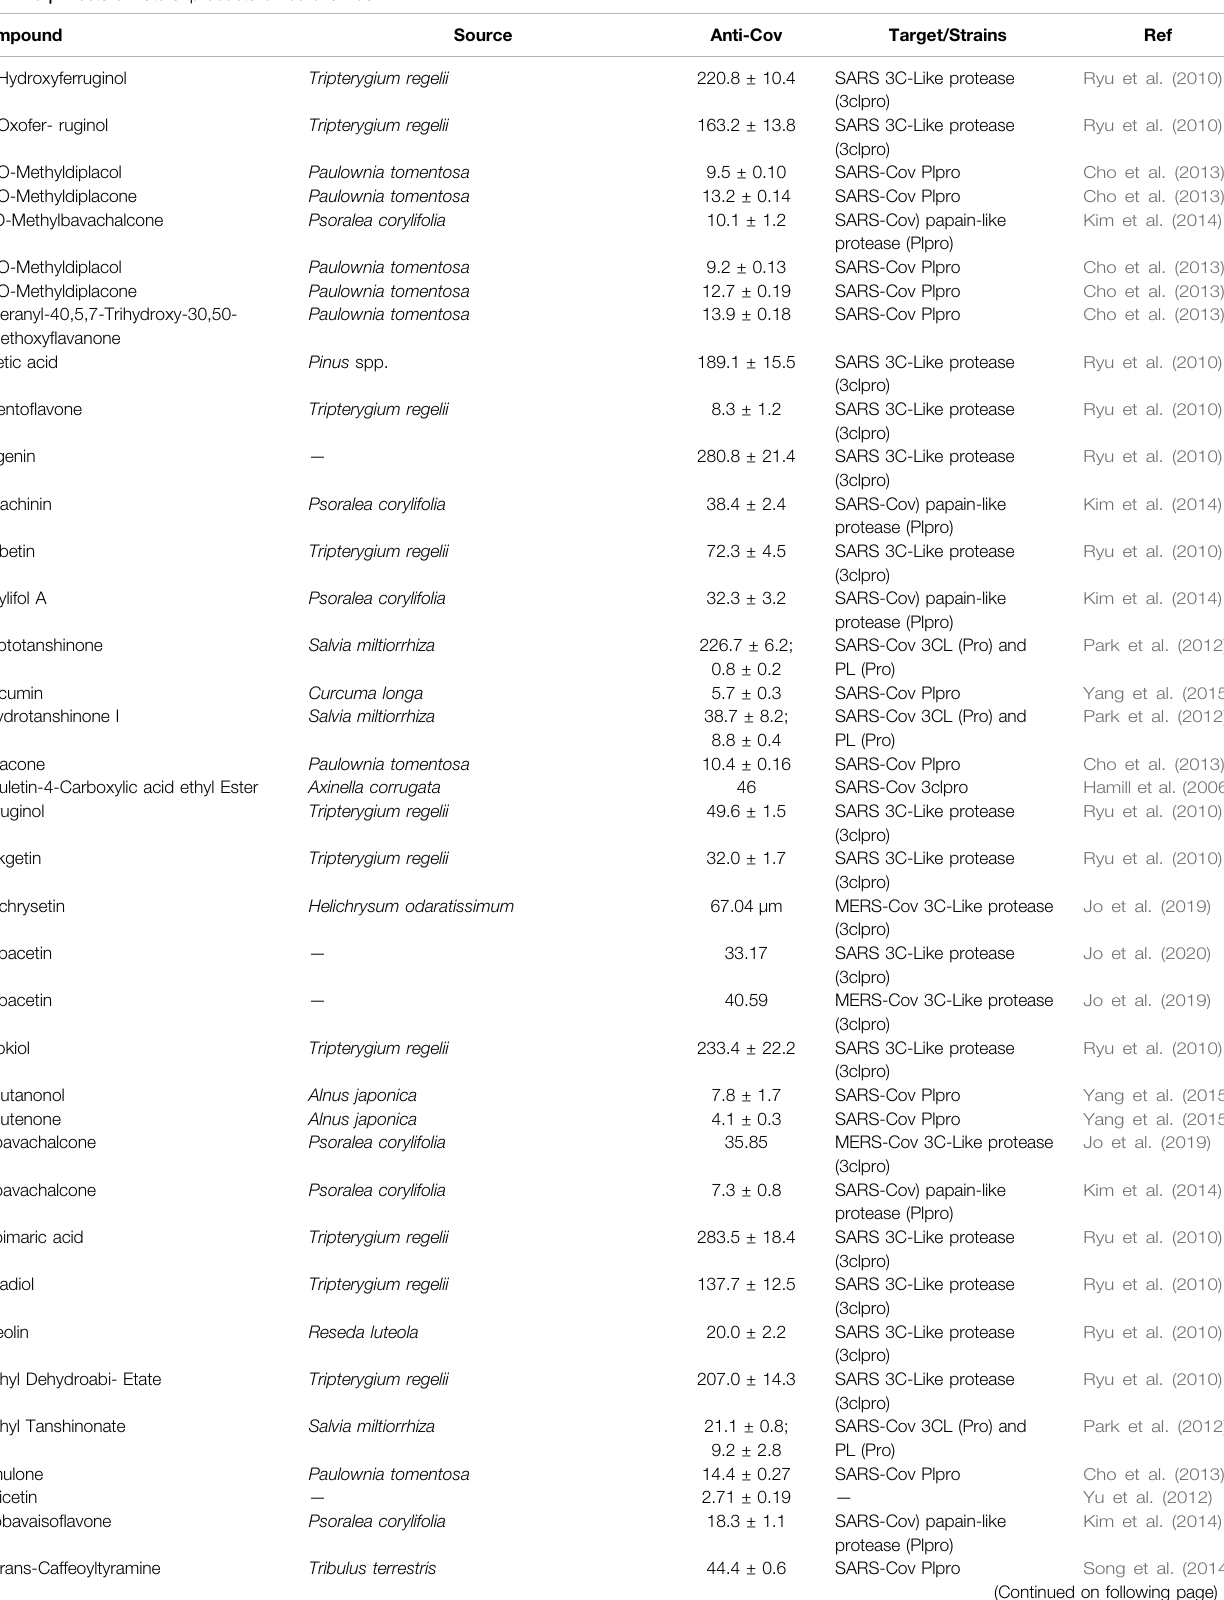
TABLE 3 | Effects of natural products on